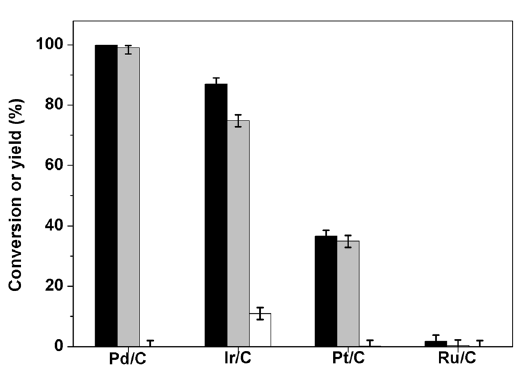
Figure 2. Isophorone conversions (black bars) and the carbon yields of compound 2 (gray bars), and compound 3 (white bars) over the different catalysts. Reaction conditions: 298 K, 1 h; 1.16 g (8.4 mmol) isophorone, 0.05 g catalyst, 2.0 MPa H 2